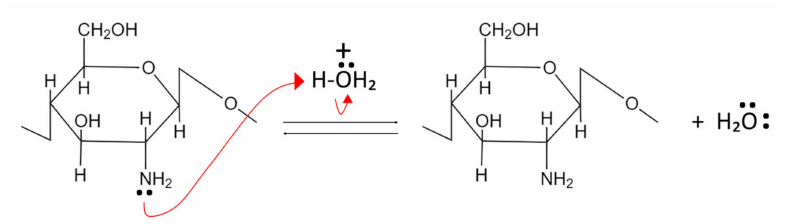
Figure 3. Neutralization reaction of chitin and CS.